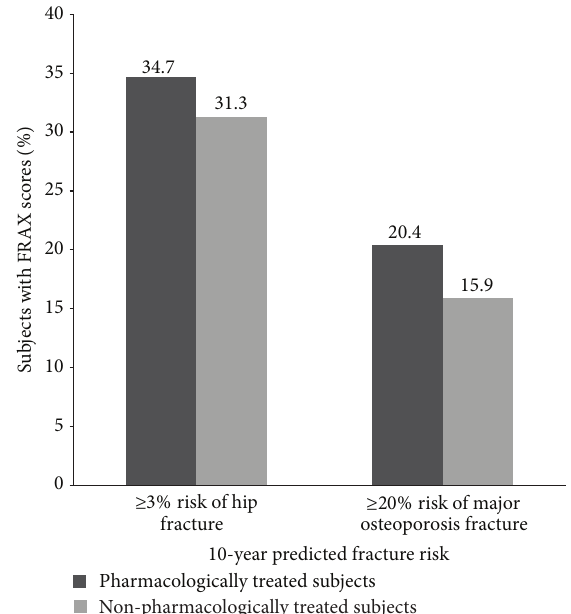
Figure 4: Percentage of subjects in the osteoporosis and osteopenia groups whose FRAX scores met or exceeded the National Osteo- porosis Foundation treatment